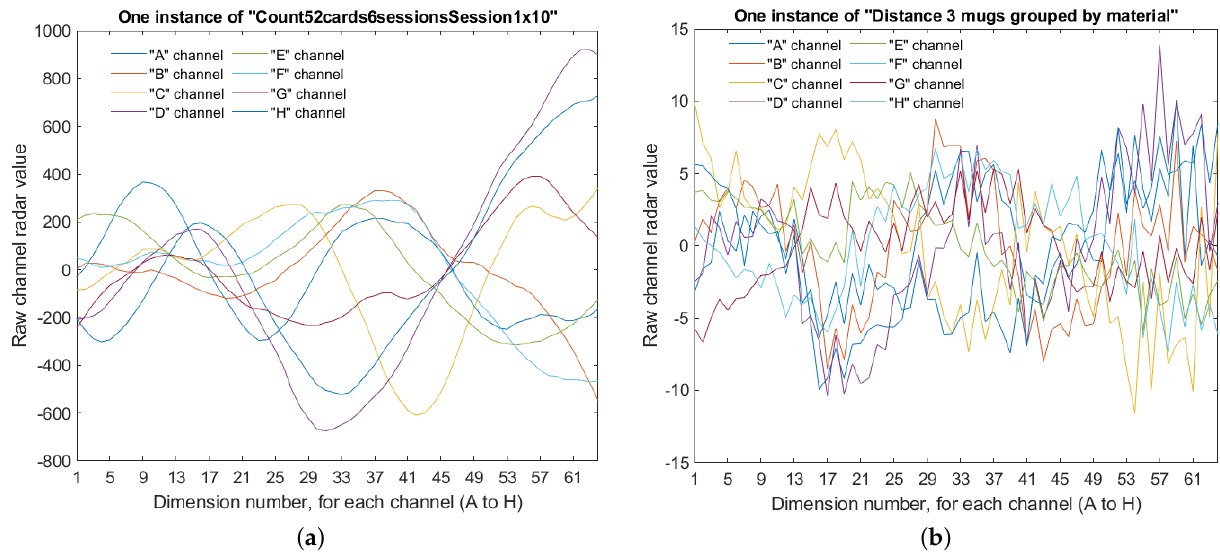
Figure 1. Plots of the eight 64D signals (one 64D signal per channel) for two instances, each of a different dataset.